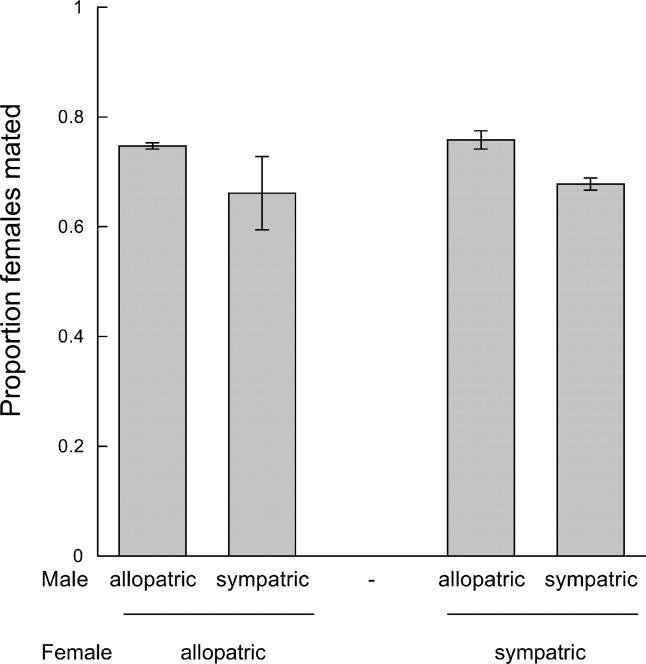
Proportion of D. recens Females from Either Sympatric or Allopatric Populations That Mated with Either Sympatric or Allopatric D. recens Males in No-Choice TestsData from different allopatric populations combined and that from sympatric strains combined. Mean ± standard error among the two replicate trials.